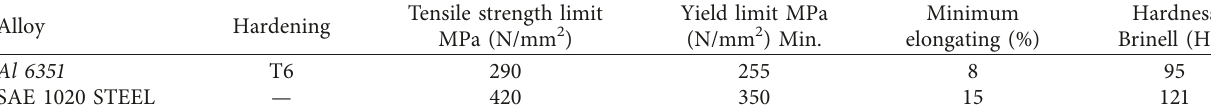
Table 2: Mechanical properties of A6351-T6 aluminum and SAE 1020 steel.